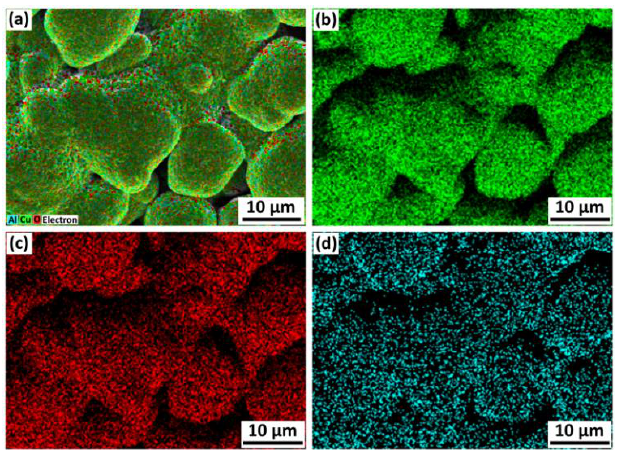
Figure 7. ( a ) EDX layered image and compositional images made by EDX elemental mapping at the microstructural level of the Al 2 O 3 /CuO-3D heterostructures for: ( b ) Cu Lα1_2; ( c ) O Kα1 and ( d ) Al Kα1 distributions.